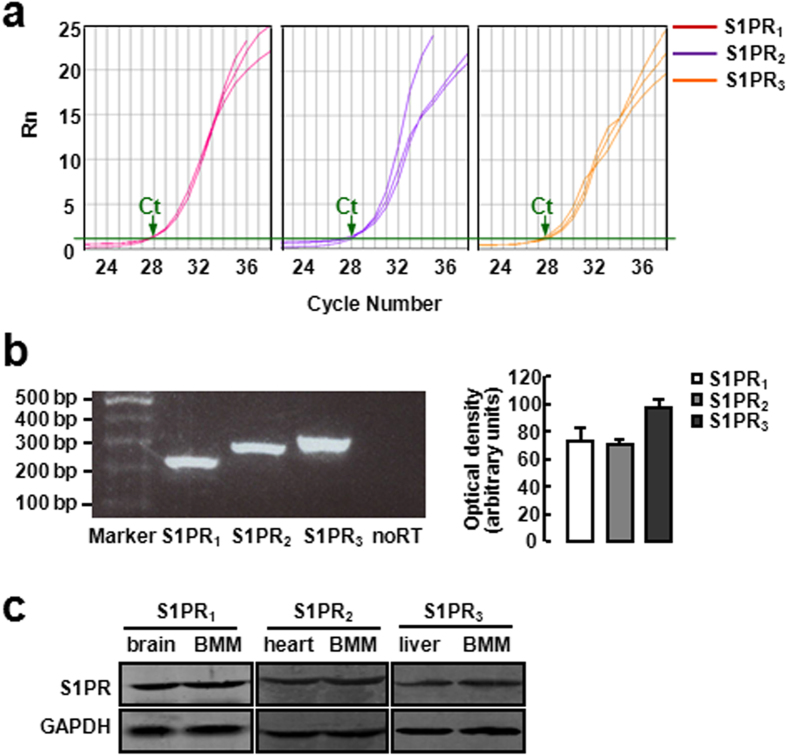
S1PR1, S1PR2 and S1PR3 are expressed in BMMs.(a) The amplification plot of S1PR1–3 expression in BMMs by real time RT-PCR. (b) The PCR products were size-fractionated in a 2% agarose gel. (c) Western blot analysis for protein expression of S1PR1–3 in BMMs. Brain, heart and liver tissue were used as positive controls.